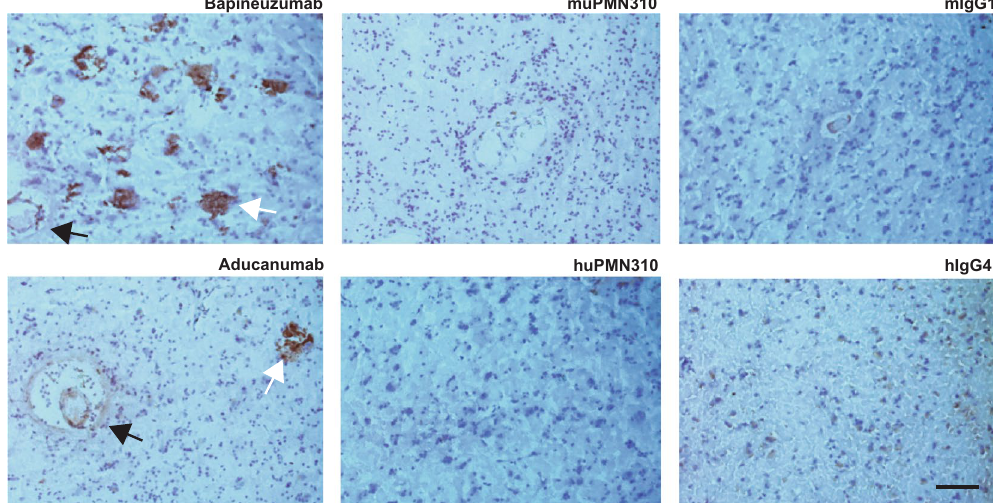
Figure 3. PMN310 does not react with A β plaque or vascular deposits in AD brain sections. Sections from the frontal cortex of human AD brain were stained with 1 μ g/ml of indicated antibodies. Detection of bound antibody with secondary anti-human or anti-mouse IgG appears in brown, and nuclear counterstaining with hematoxylin in blue. The images are representative of 3 or more independent experiments with four individual AD brains. Scale bar = 100 μ m, applicable to all images. White arrows - characteristic plaque staining; black arrows - A β vascular deposit